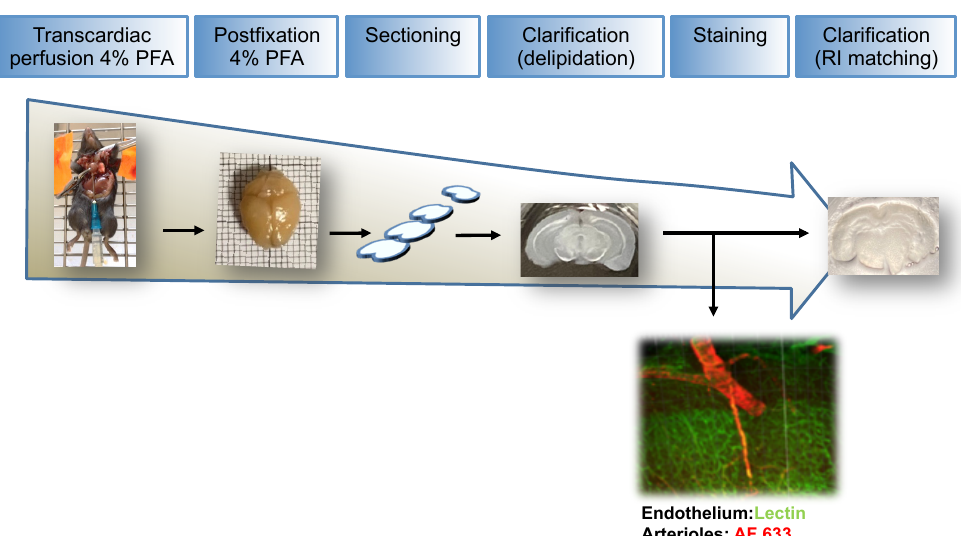
Figure 1. From mouse transcardiac perfusion to staining and cleared